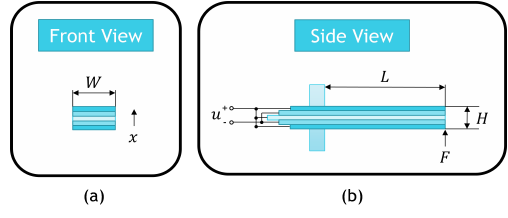
Fig. 1: Piezoelectric bimorph actuator. (a) front view (b) side view When a voltage u is applied to a piezoelectric actuator, a force F is generated and the resultant displacement is given by x . The equation that describes the motion of a piezoelectric bimorph actuator is described as [29,30]